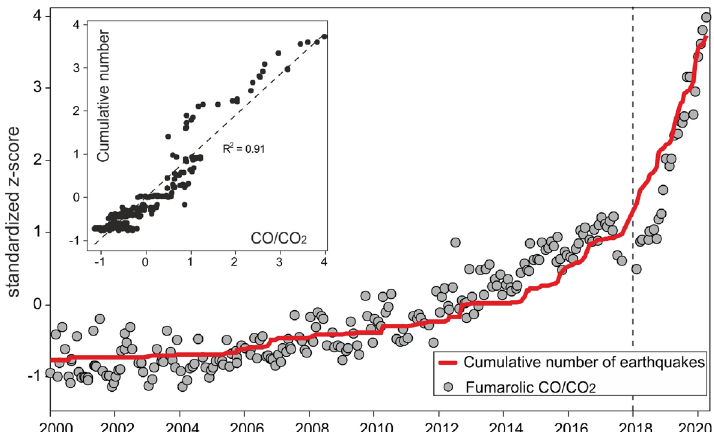
Figure 6. CO/CO 2 fumarolic ratio and cumulative number of earthquakes normalized with the z-score method. The inside panel shows the same variables one versus the